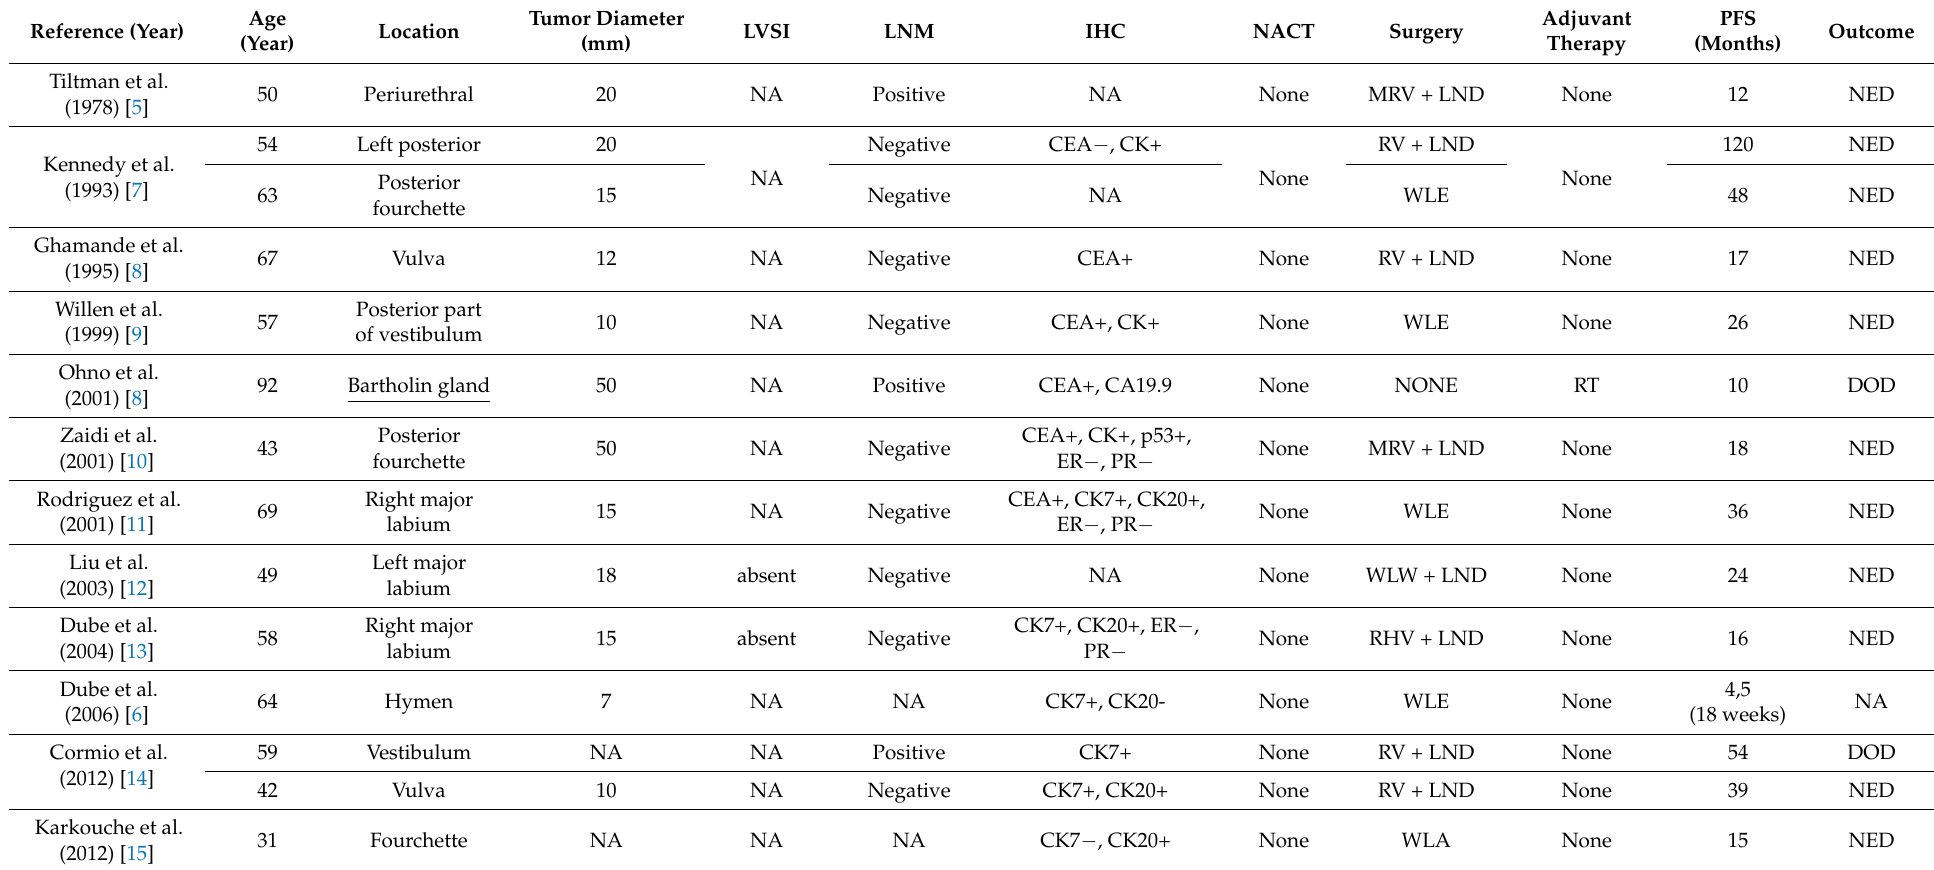
Table 1. Overview of cases of intestinal-type mucinous adenocarcinoma of the vulva in the literature revised until April 2022. Table Legend: MRV = modified